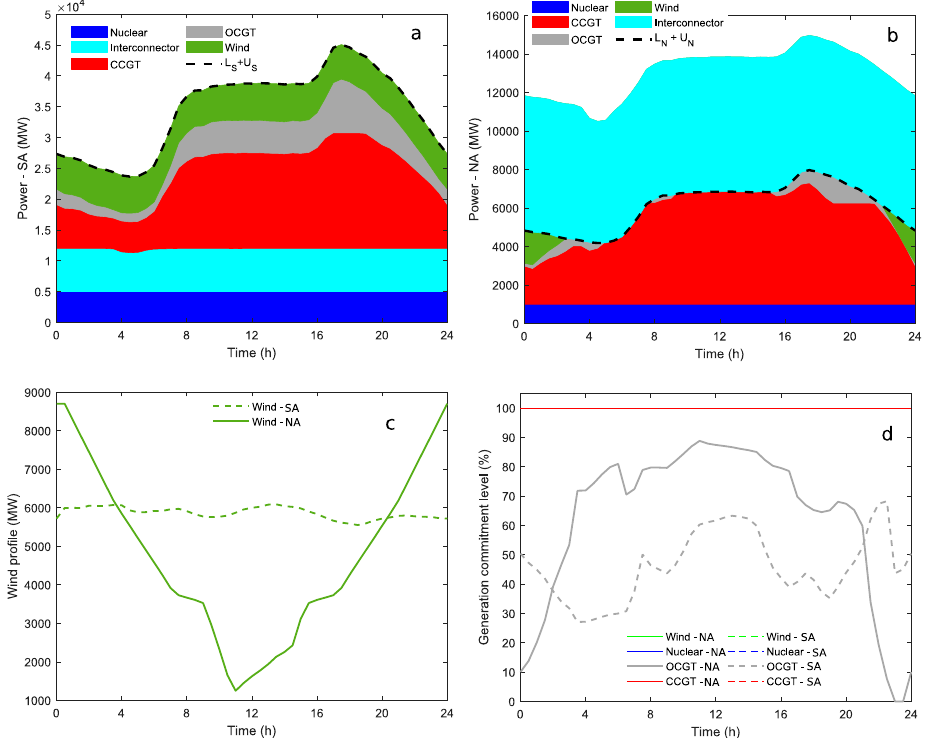
Figure A1. ( a ) Generation mix in the SA. ( b ) Generation mix in the NA. ( c ) Available wind generation in the NA and SA. ( d ) Percent generation commitment levels in the NA and